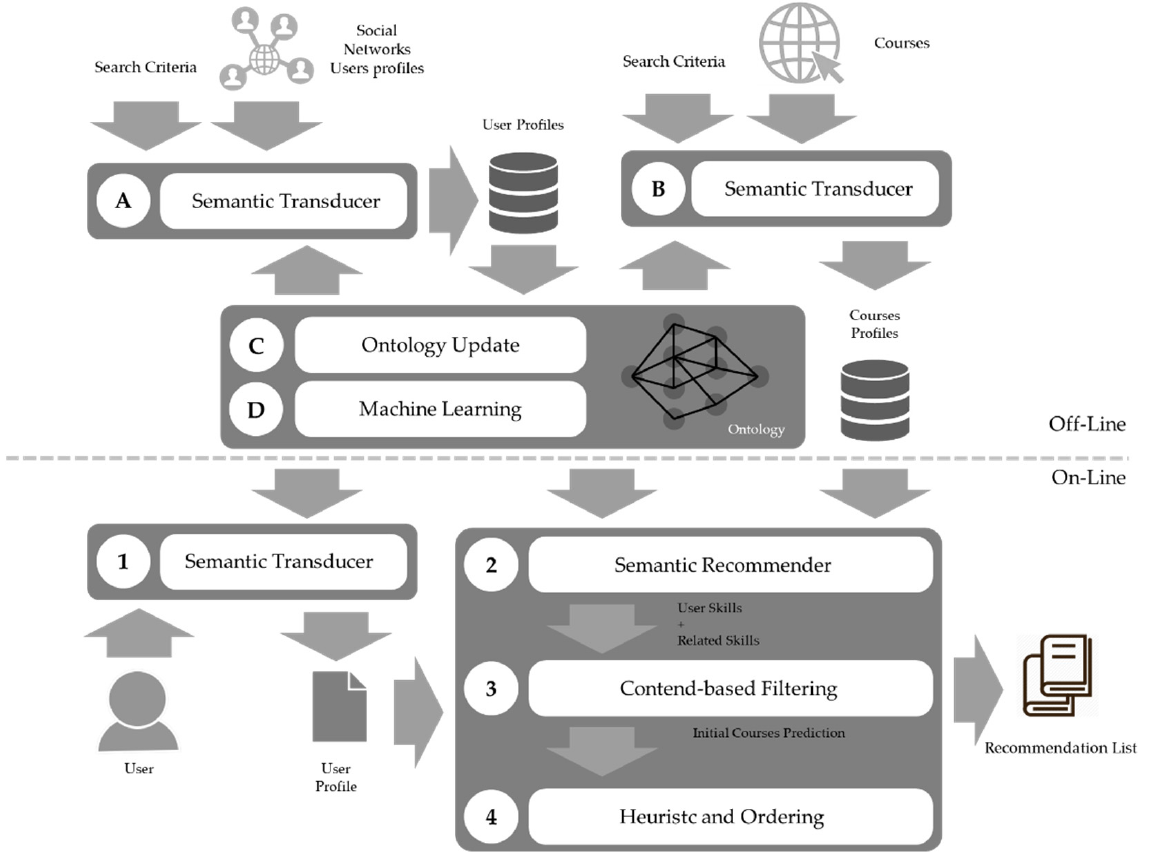
Figure 1. Recommendation System Flow.